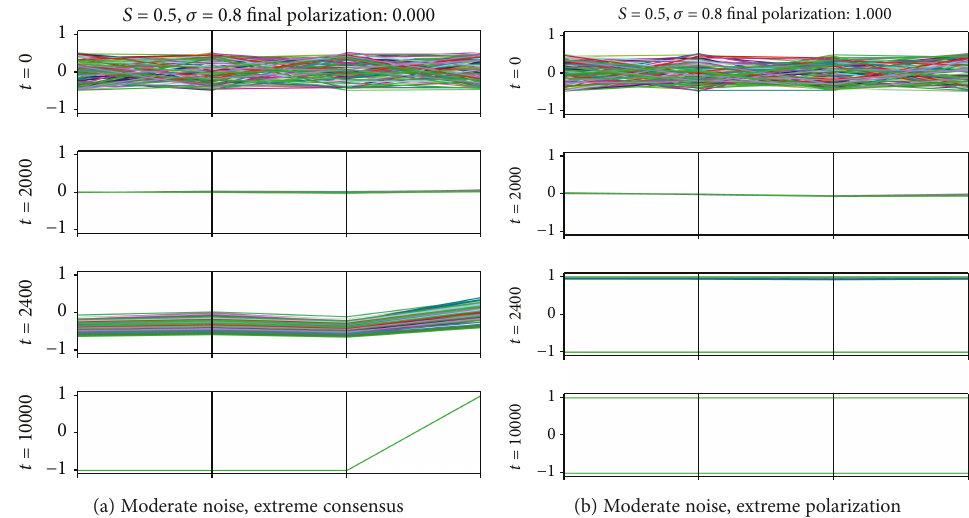
Figure 16: Exemplar parallel coordinate time series for K = 4 and S = 0 5 . Here, the x -axis represents a single opinion coordinate, k y -axis is the location of an agent for that coordinate. Each agent is represented by a line, colored by cave membership. With σ = 0 1 , consensus emerges but at a corner of the opinion